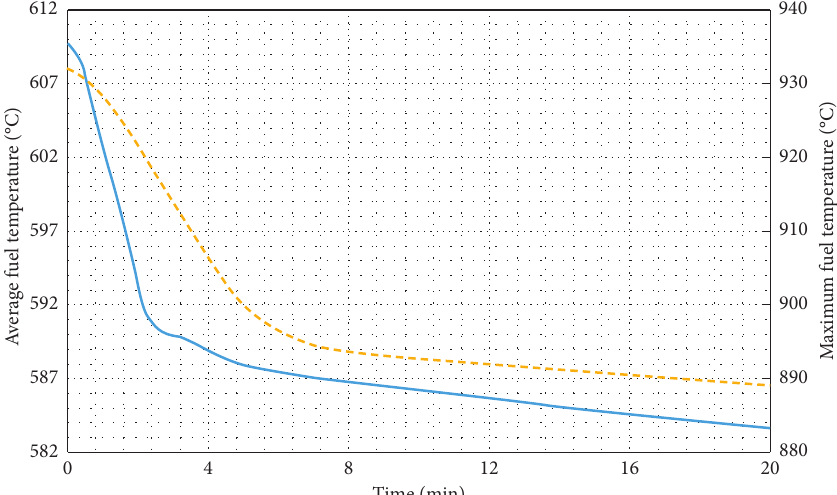
Figure 16: Average and maximum fuel temperature of #2 module in case 2 (solid line: average; dashed line: maximum).